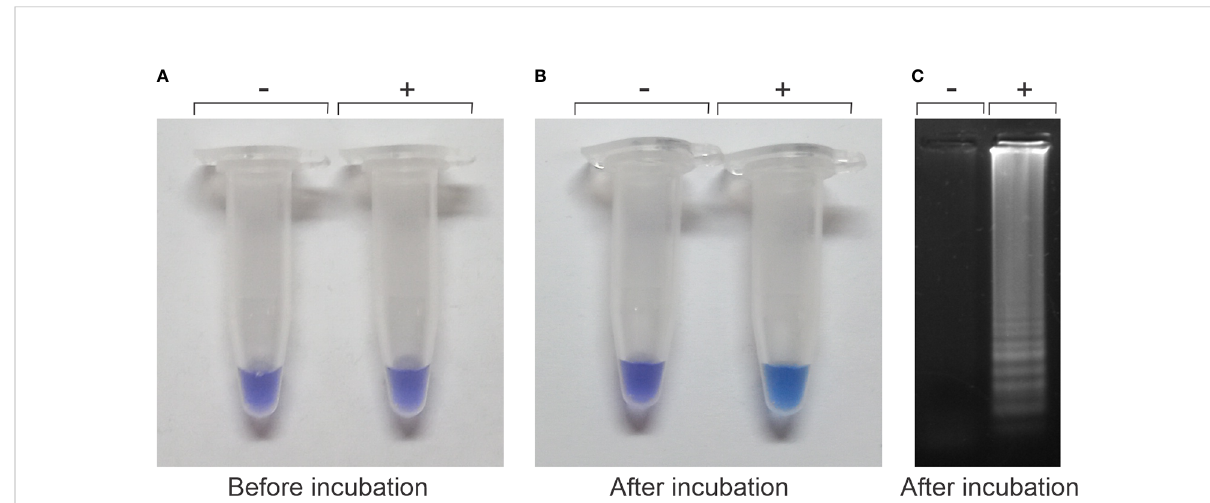
FIGURE 1 Visualization of color changes from violet to blue/light blue before or after the loop-mediated isothermal ampli fi cation (LAMP) reaction. (A) The reaction tubes, a negative and a positive control, before incubation are both violet, indistinguishable from each other. (B) They differ after the incubation period where the positive control (+) changes to light blue, whereas the negative control remains violet ( − ). (C) Visualization of the LAMP-banding pattern of DNA by agarose gel electrophoresis of the positive reaction observed in panel (B)